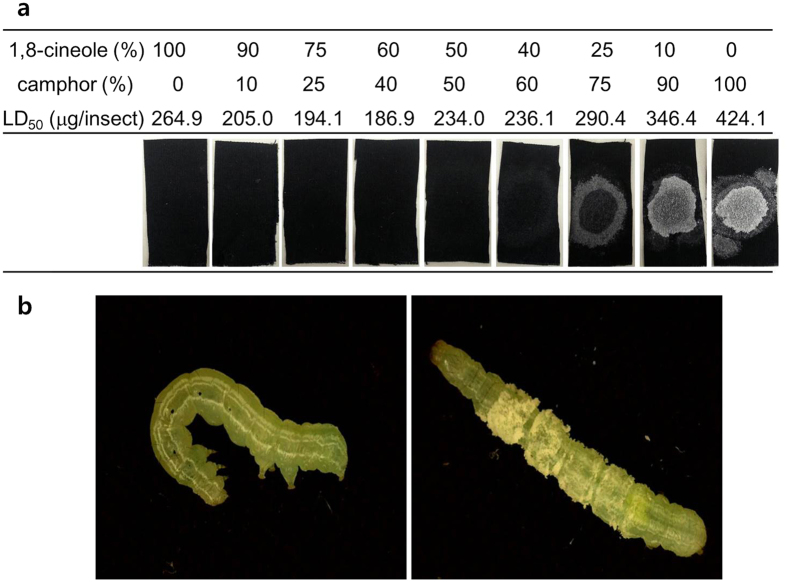
Direct correlation between insecticidal activity and solubility of camphor in binary mixtures with 1,8-cineole.(a) Application status of the binary mixture in different blending ratios, and (b) difference in recrystallization of camphor (left; 1,8-cineole:camphor = 75:25, right; camphor alone).